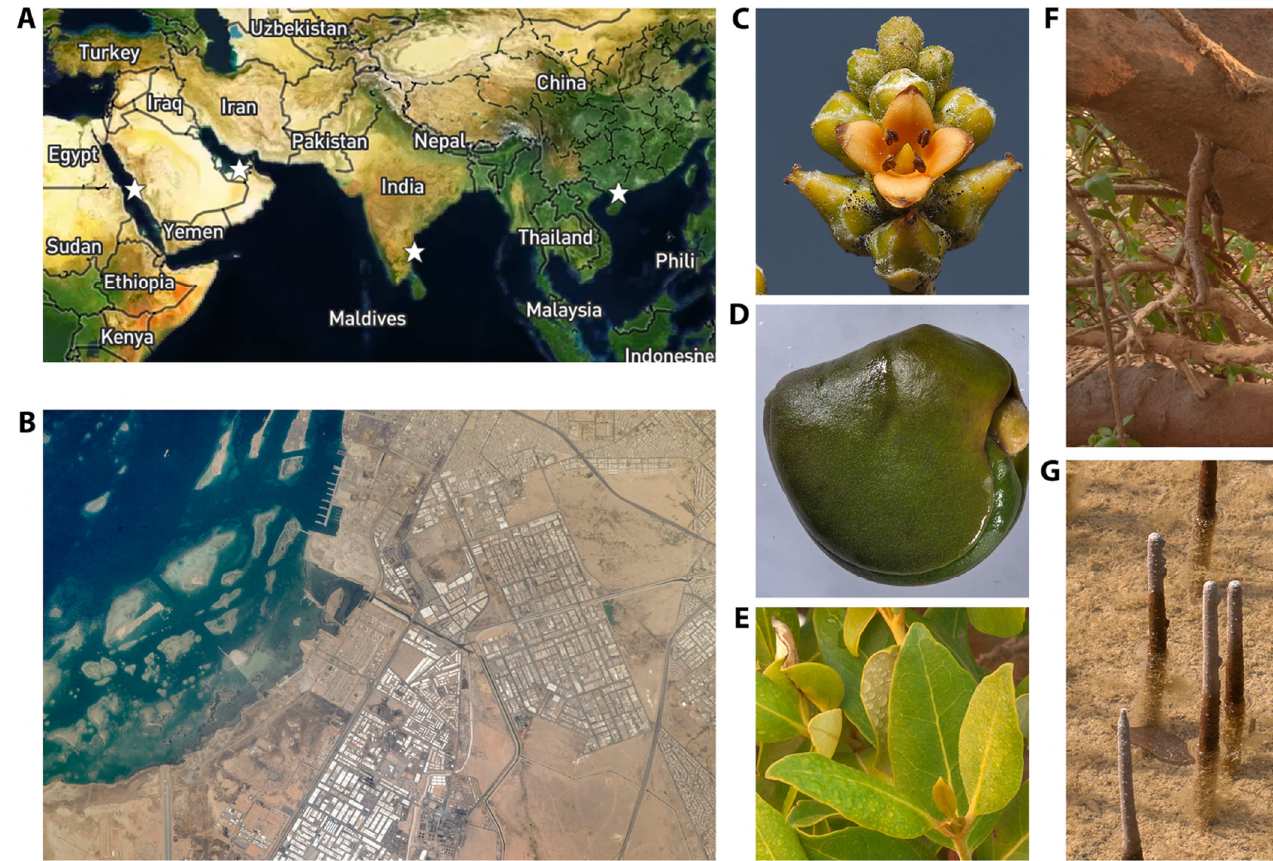
Figure 1. Overview of the RNAseq data source tissues and geographies. ( A ) Locations (stars) of the A. marina RNAseq samples. Map and location visualized in Plotly. ( B ) Jeddah Port, showing the industrialization near the Red Sea mangrove sampling site. Image courtesy of NASA. ( C ) A. marina flowers. ( D ) A. marina seeds. ( E ) A. marina leaves. ( F ) A. marina stems. ( G ) A. marina pneumatophores. Mangrove tissue photos reproduced with permission from Dr. Alexey Sergeev.